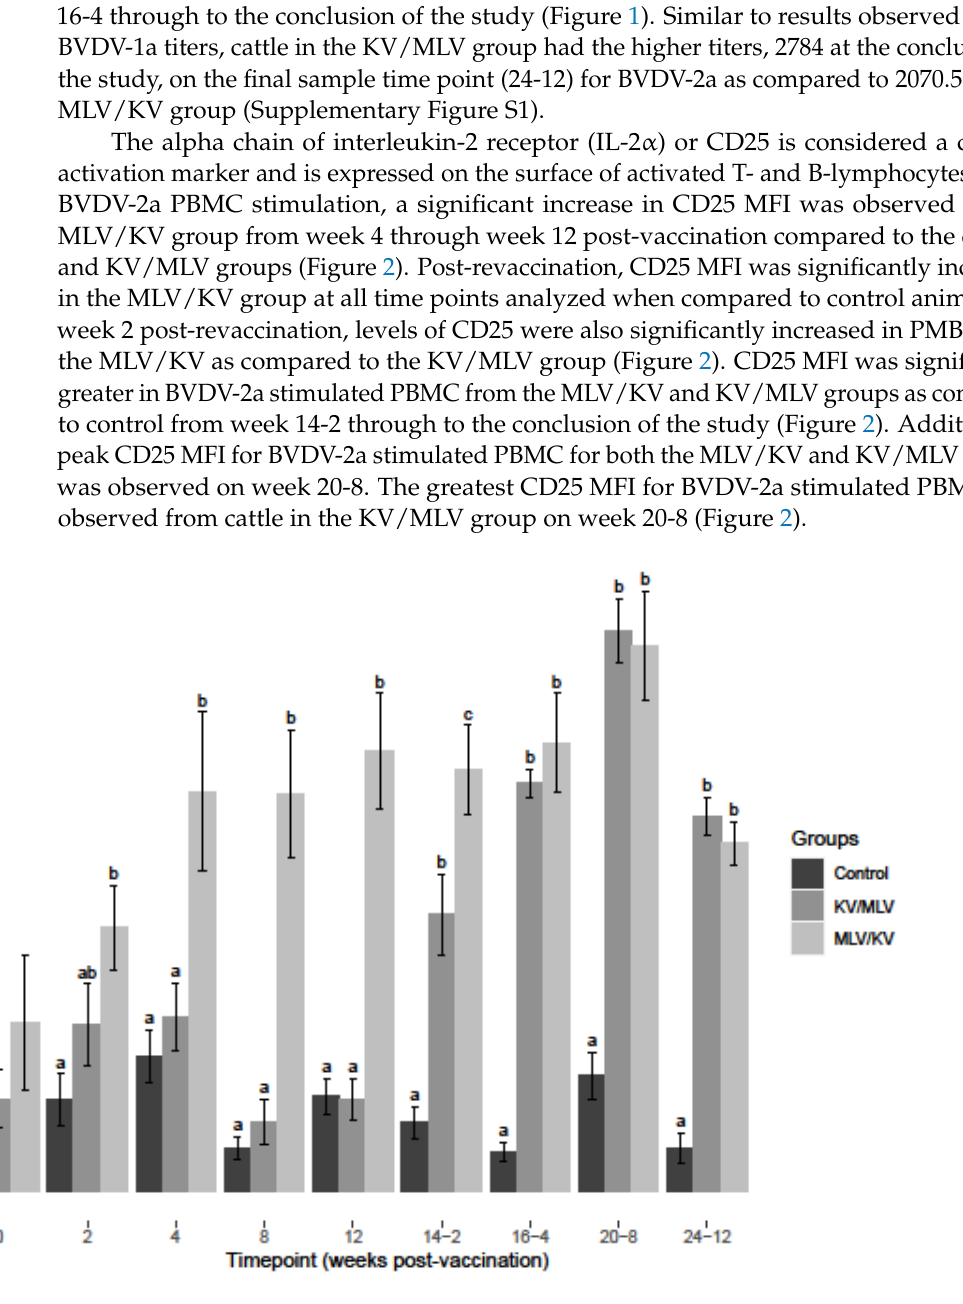
Figure 2. Average mean fluorescent intensity (MFI) for CD25 + (IL-2 α receptor) PBMC after 24-h stimulation at each respective timepoint over the course of the study with BVDV-2a (PI-28). Values at each timepoint, not connected by the same letter are significantly different ( p < 0.05).